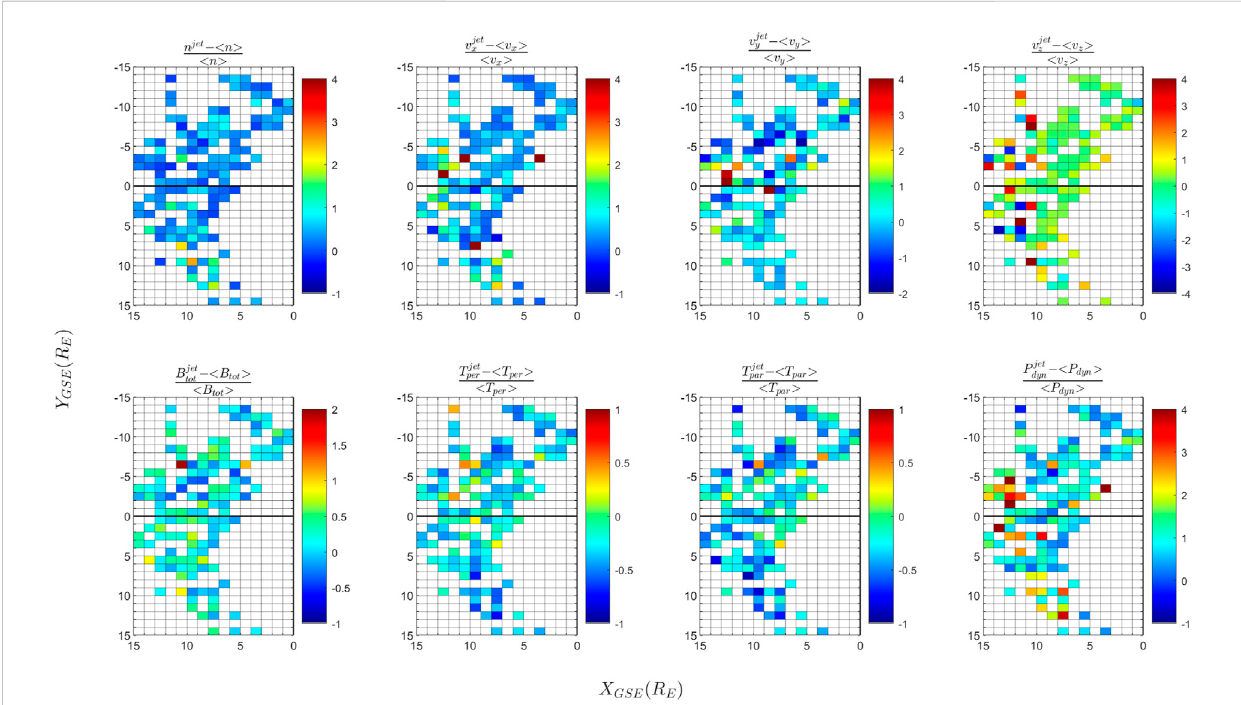
FIGURE 7 Relative perturbation of the background magnetosheath state produced by jets, illustrated for each physical quantity included in Figure 6, for data recorded in 2008. Same format as Figure 5.